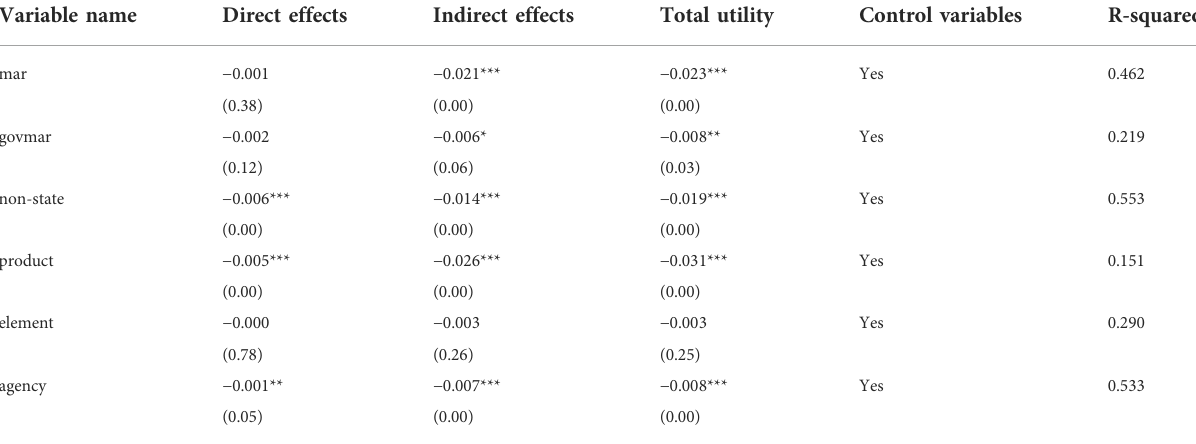
TABLE 7 Decomposition of the spillover effect on the business environment on the urban – rural income